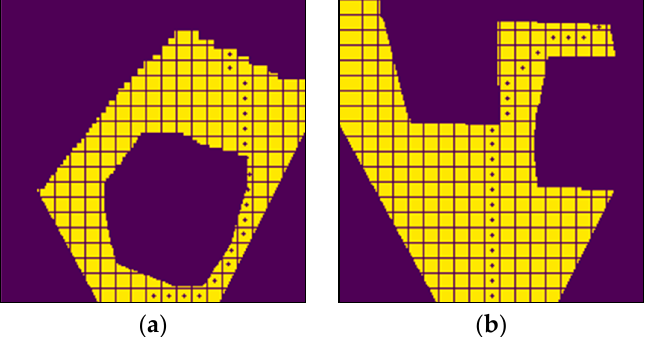
Figure 17. Path planning in the collision-free area in the conventional A* path: ( a ) having one obstacle at the bottom of the environment, ( b ) having two obstacles at the top of the environment.